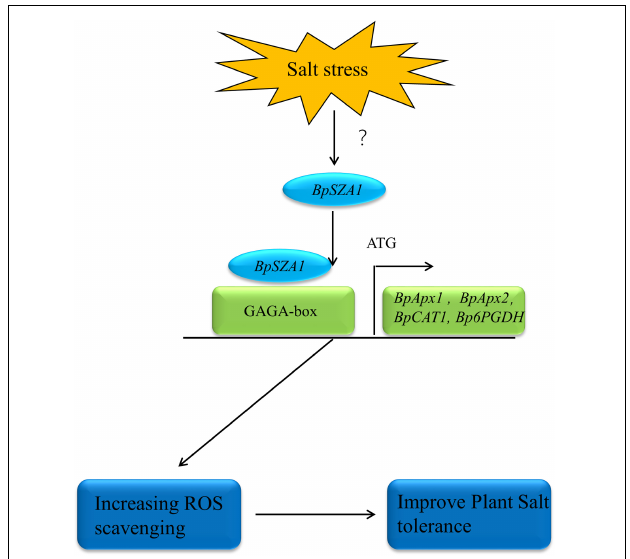
FIGURE 8 | The model of BpSZA1 regulation network in response to Salt stress. Salt stress signals activate the expression of upstream genes of BpSZA1, which in turn activates BpSZA1 . BpSZA1 binds to the GAGA-box in the promoter region, thereby activating the expression of downstream genes such as BpAPX1 , BpAPX2 , BpCAT , and Bp6PGDH to increase ROS scavenging. The result is tolerance to salt stress is increased in the